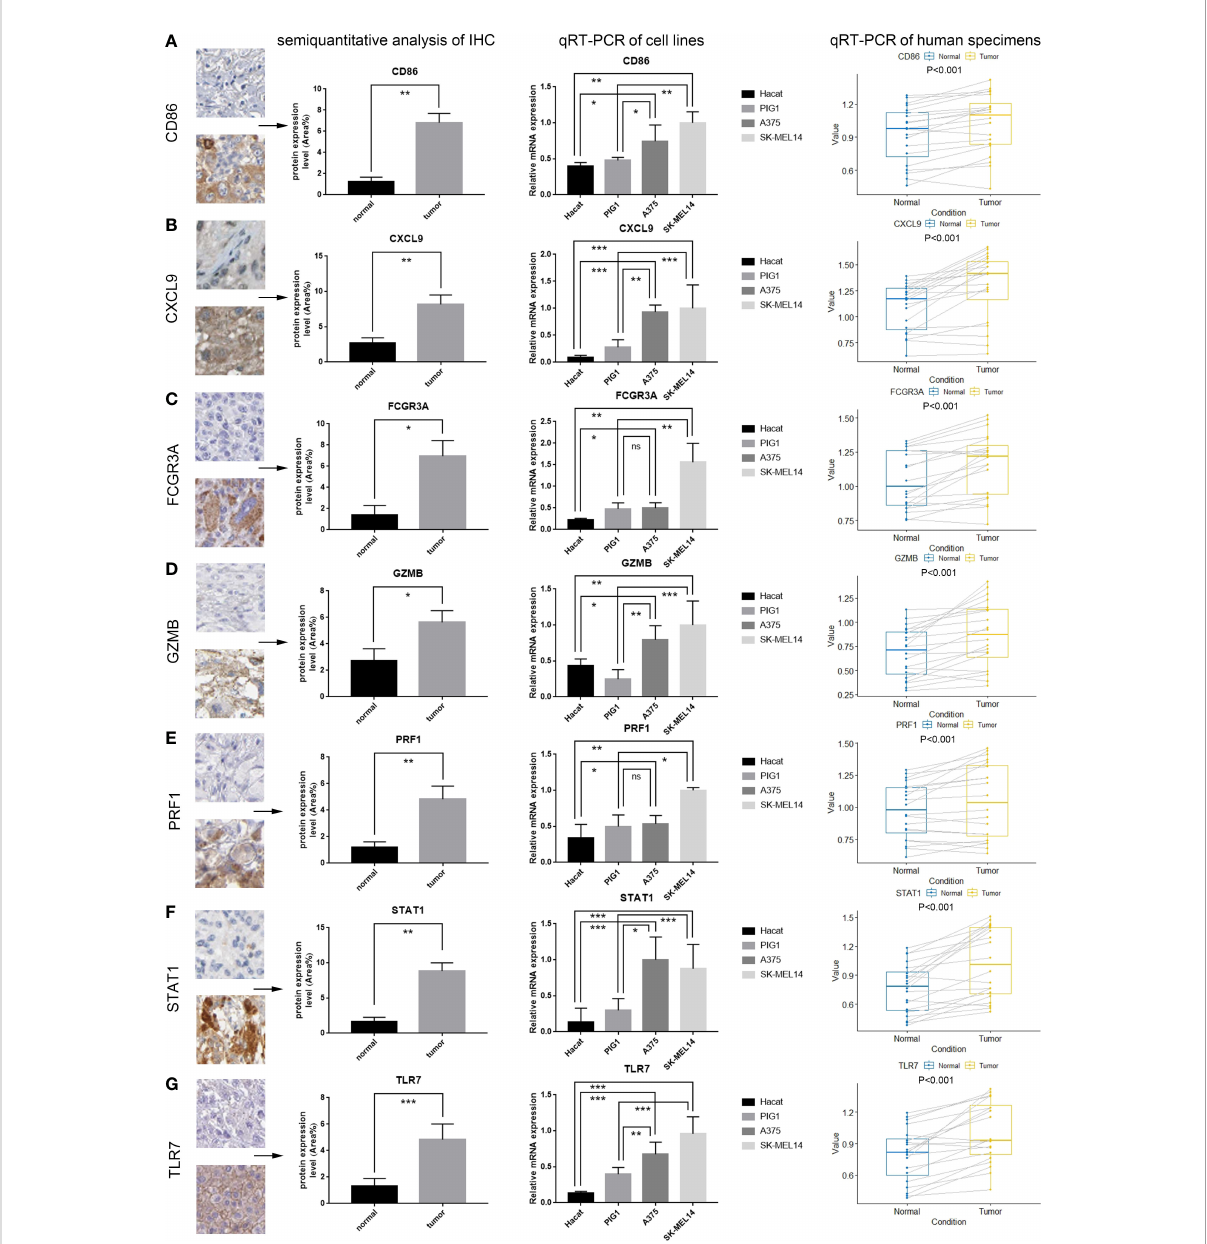
FIGURE 10 Validation of the mRNA and protein expression of seven key genes. The results of the fi rst column represent the semiquantitative analysis results obtained from the IHC results downloaded from the human protein atlas (see Figure 3 for a complete view of the immunohistochemistry images). The results of the second column represent the qRT-PCR results from four cell lines (Hacat, PIG1, A375 and SK-MEL 14). The results of the third column represent the qRT-PCR results of tissue specimens from 20 patients, which were taken from normal skin and